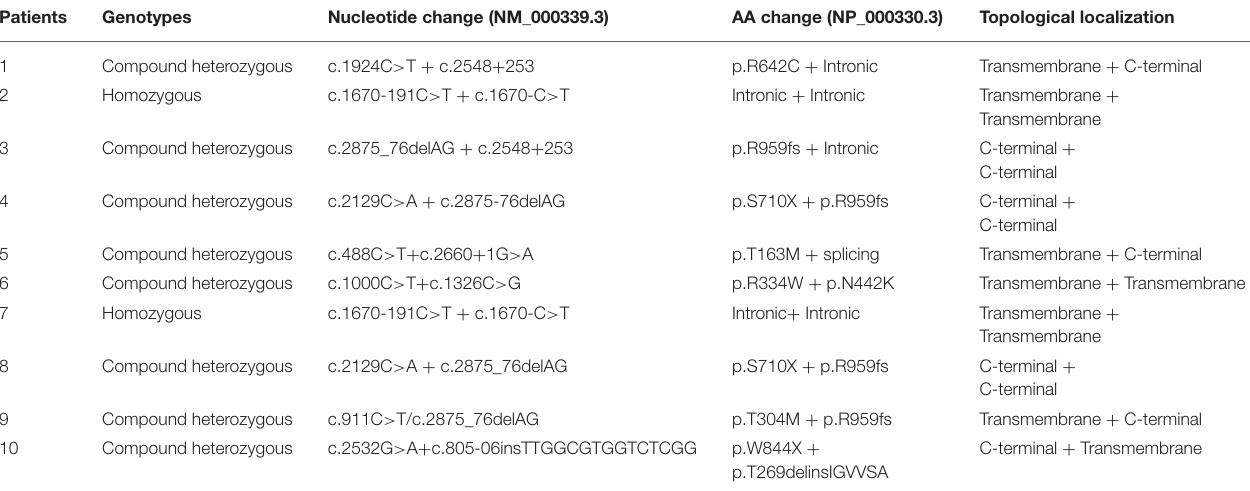
TABLE 1 | Characteristics of SLC12A3 mutation among 10 patients with Gitelman syndrome.